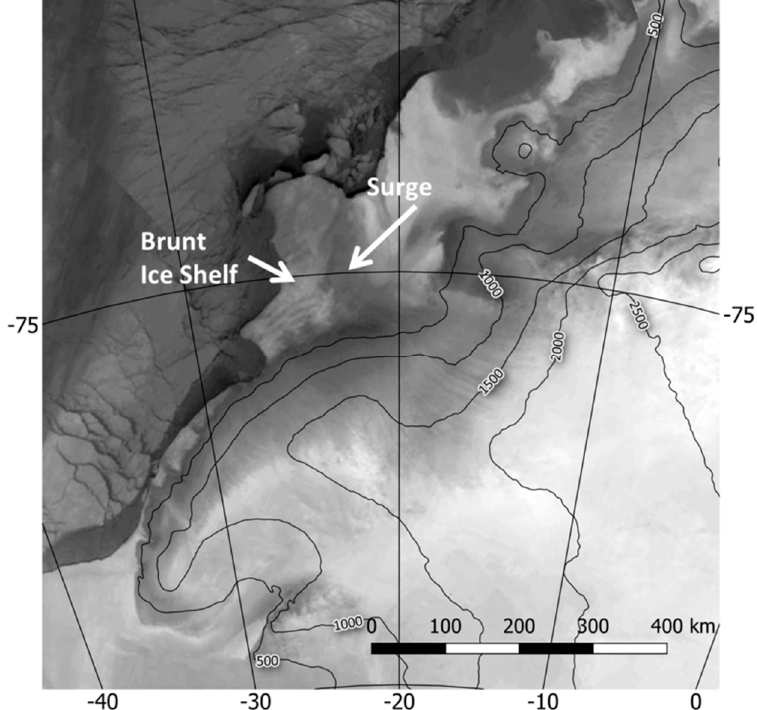
Figure 3. Example of katabatic warm signatures (Moderate Resolution Imaging Spectroradiometer (MODIS) IR image 2 August 2015, warm = dark, data source: NASA Worldview) and topography from Cryosat-2 data [19]).